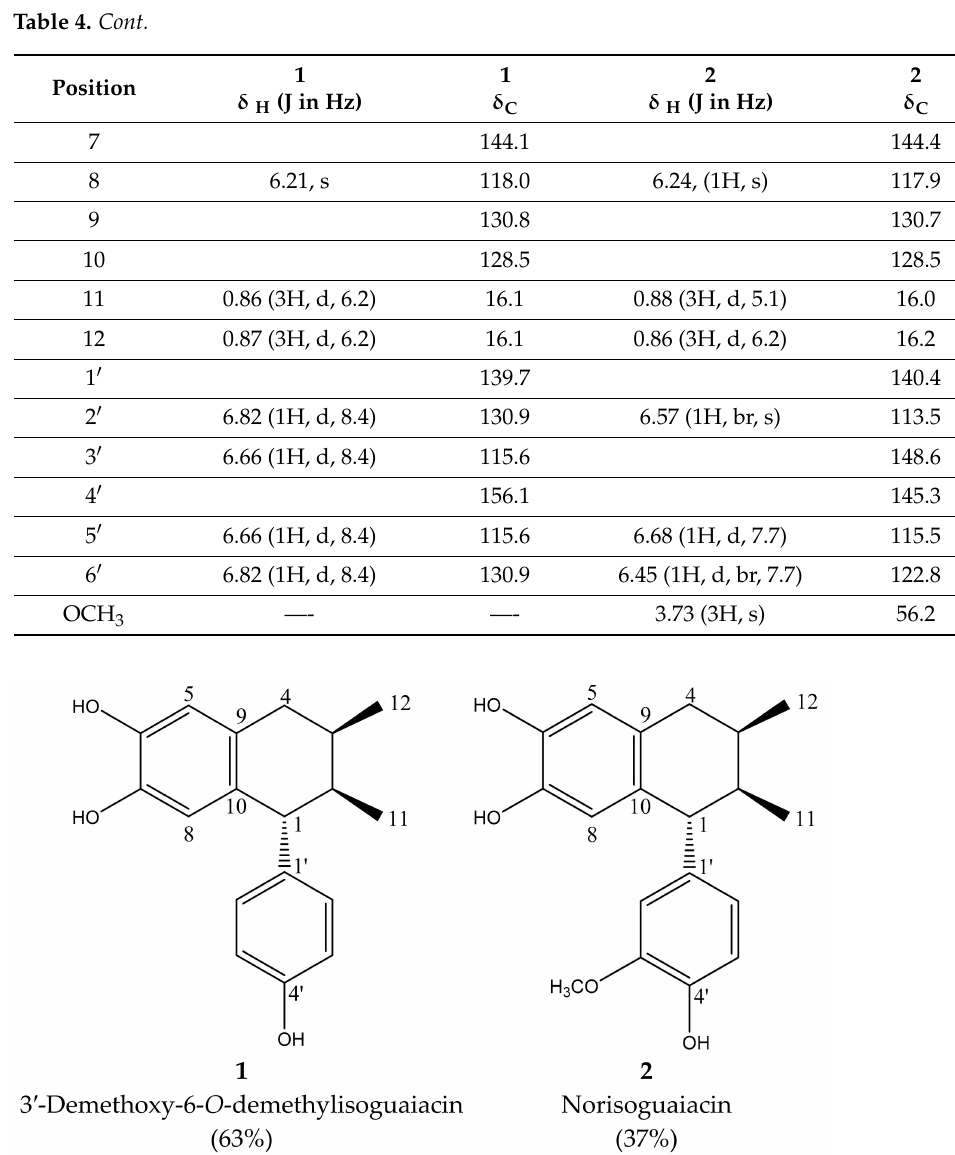
Figure 1. Chemical structure of 3 (cid:48) -demethoxy-6-O-demethylisoguaiacin (1) and norisoguaiacin